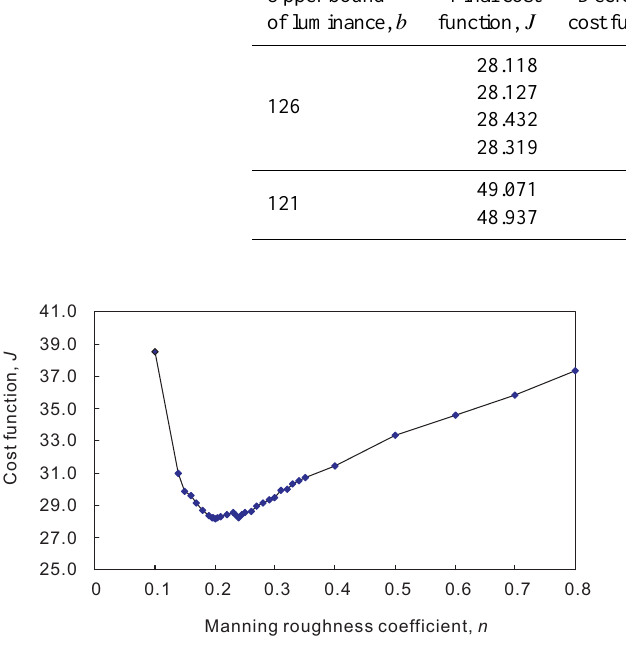
Figure 11. The relationship between the cost function and the Man- ning’s n